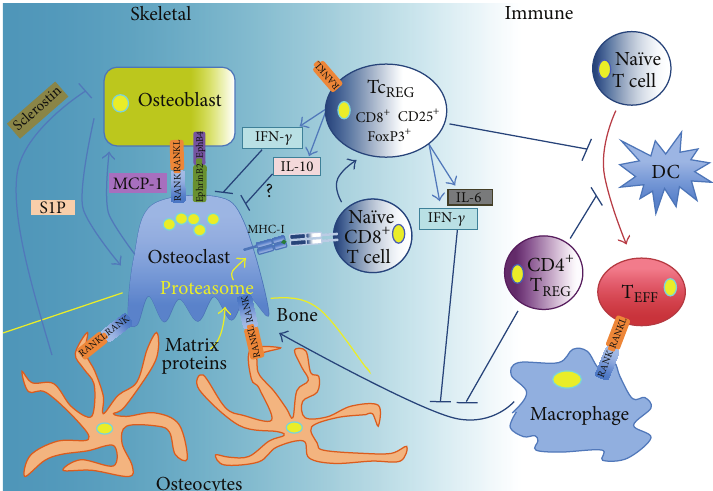
Figure 3: Regulatory network between the bone and immunesystem: the figureshows thenetwork architecture of regulatory interactions that maintain homeostasis of the skeletal systems. Osteoclast-induced FoxP3 + CD8 T cells are capable of regulating the skeletal and the immune